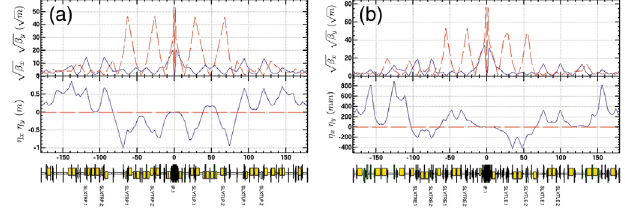
FIG. 5. Optical functions of SuperKEKB interaction region: